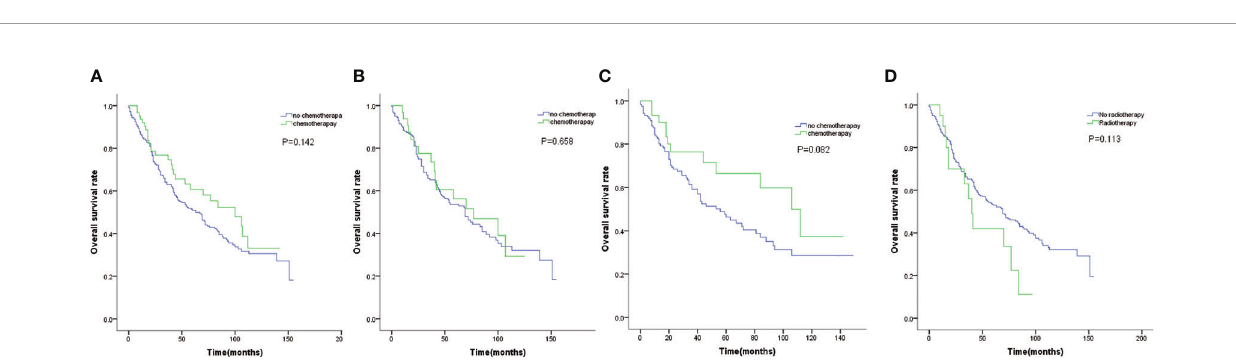
FIGURE 2 | (A) OS for patients by chemotherapy. (B) OS for patients with tumor size smaller than 2cm by chemotherapy. (C) OS for patients with tumor size 2 to 3 cm by chemotherapy. (D) OS for patients by radiotherapy.